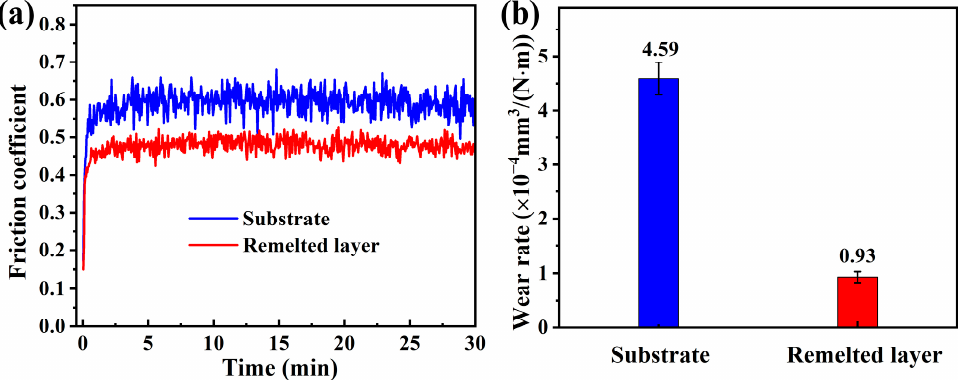
Figure 7. Tribological test results. ( a ) Friction coefficient; and ( b ) wear rates.